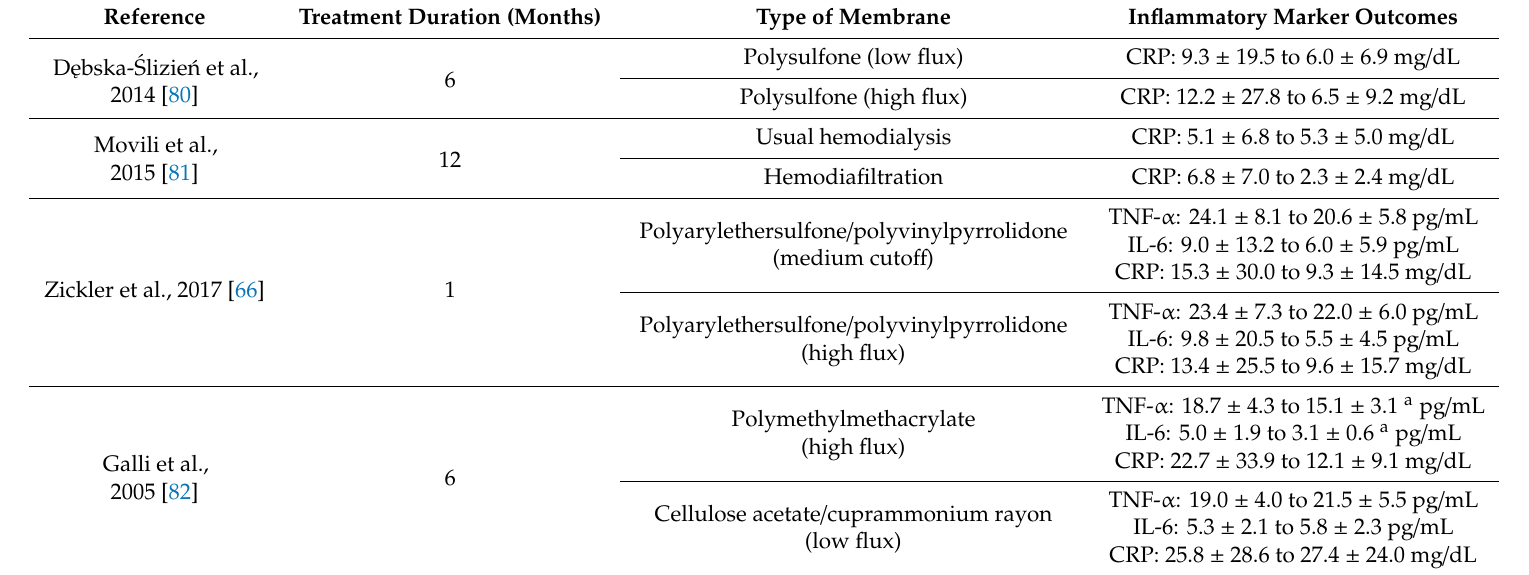
Table 4. E ff ects of type of dialyzer membranes on inflammation